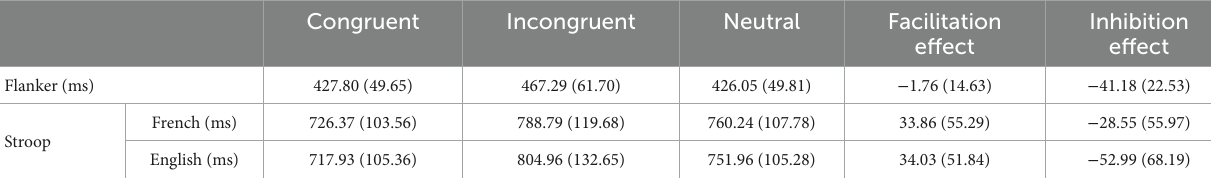
TABLE 4 Descriptive statistics for both the Flanker ( n = 217) and Stroop ( n = 218)